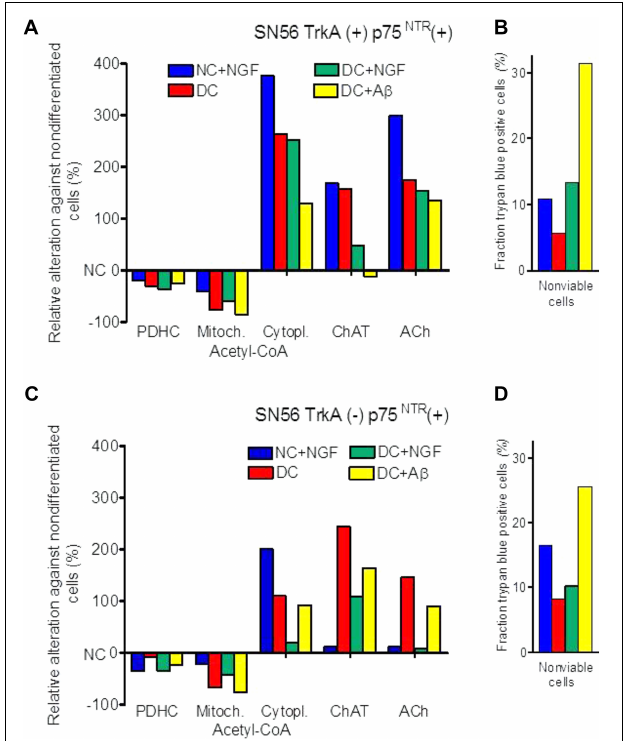
FIGURE 2 | Effects of cholinergic differentiation with dibutyryl-cAMP/RA (DC) and/or with nerve growth factor (NGF) and amyloid- β (A β ) on PDHC and ChAT activities, acetyl-CoA distribution, acetylcholine content and loss of viability of (A,B) cholinergic neuroblastoma SN56 with surface TrkA(+) and p75 NTR (+) NGF receptors; (C,D) SN56 with TrkA(–) and p75 NTR (+) NGF receptors. Absolute values of enzyme activities and metabolite levels corresponding to 0 ordinate are given in Table 3 .